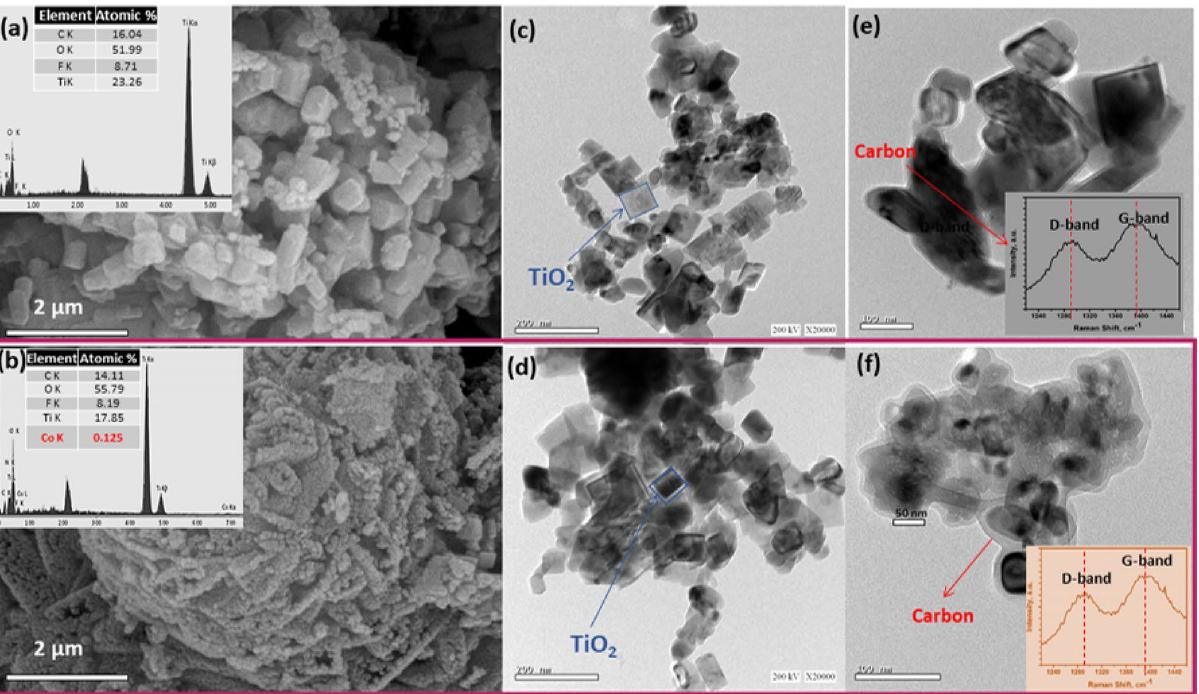
Figure 3. ( a , b ) FESEM images, ( a , b insets) EDX analysis, ( c – f ) HR-TEM images and ( e , f insets) Raman spectra of bare and Co-doped TiO